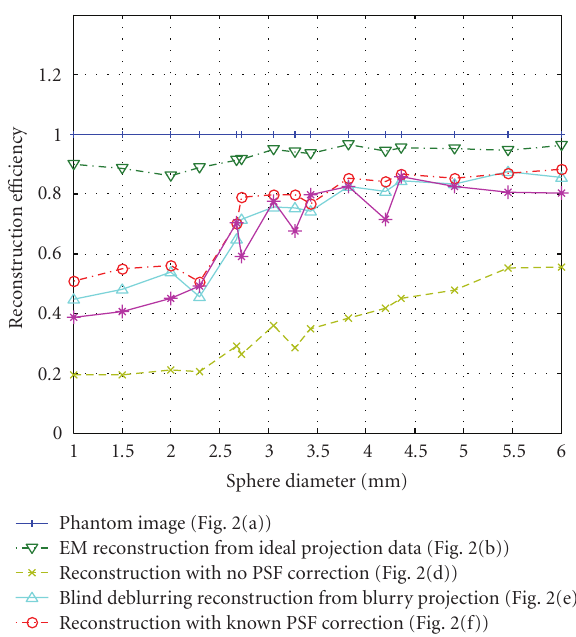
Figure 4: Reconstruction e ffi ciency for spheres with di ff erent diam- eters.